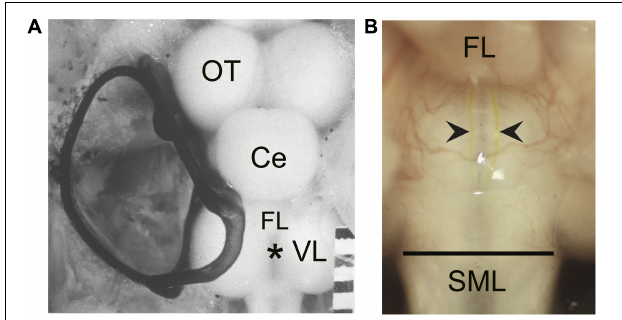
FIGURE 1 | The wound site and visual identification of Mauthner axons (M-axons). (A) Goldfish brain with the left set of semicircular canals filled with India ink. An asterisk marks the location enlarged in panel (B) . Distance between calibration marks = 1 mm. Ce, cerebellum; OT, optic tectum; FL, facial lobe; VL, vagal lobe. (B) Goldfish hindbrain in which the medulla oblongata has been exposed (see section “Materials and Methods”). Wound site is at the caudal border of the vagal lobes near the junction of the medulla oblongata and spinal cord (spinomedullary level, SML). The M-axon comes within 100 µ m of the surface of the medulla oblongata and is visible between the vagal lobes with the aid of a dissecting microscope. As a result, the M-axons can be reliably penetrated for recording, stimulation, and dye injection. Successful Lucifer yellow fills of M-axons are indicated by arrowheads just caudal to the facial lobe (FL). The dye can be seen with tungsten light. The diameter of the spinal cord just caudal to the vagal lobes is about 2 mm. The orientation of the brain is with rostral at the top and caudal at the bottom in this and all subsequent